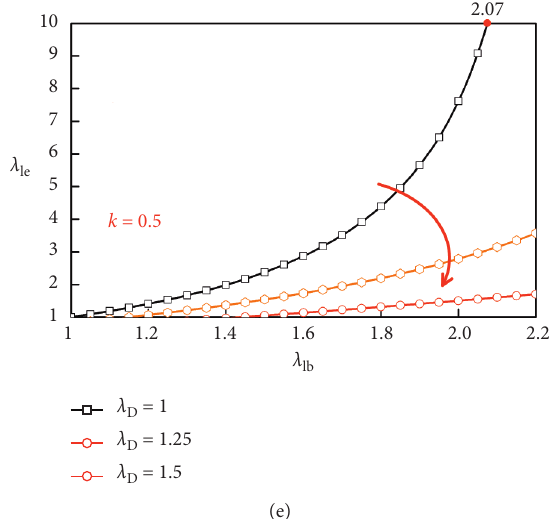
Figure 4: Corresponding relation of λ (e) k �